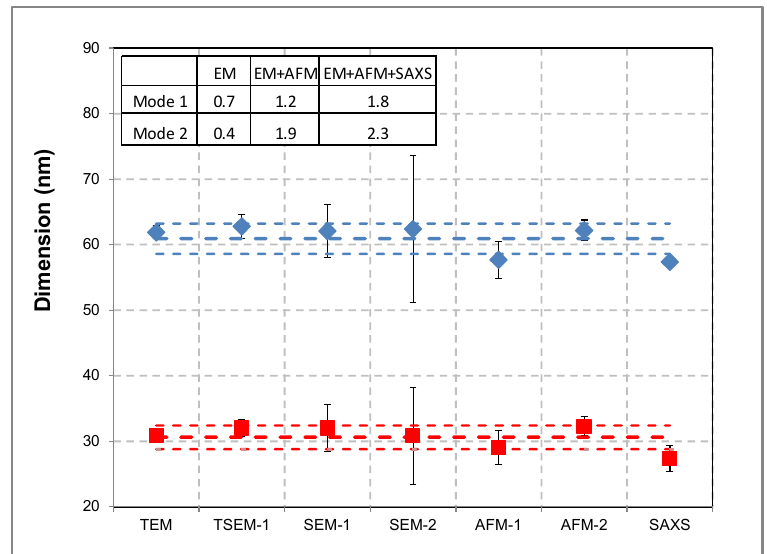
Figure 1. Size measurements of nPSize01 material (bimodal nanogold) performed with different techniques and by several laboratories. D eq was determined by TEM, TSEM, and SEM, h AFM was determined by AFM, and D SAXS was determined by SAXS. Modes 1 and 2 are represented by red and blue symbols, respectively. The table in the inset gives the data spread calculated with standard deviations by taking into account the measurements by EM (electron microscopy) only, EM + AFM, and EM + AFM + SAXS. The uncertainty bar (k = 2) for some points is not visible when the associated uncertainty is too small. The dotted lines correspond to the mean value associated with the standard deviations calculated from the results obtained by all techniques.